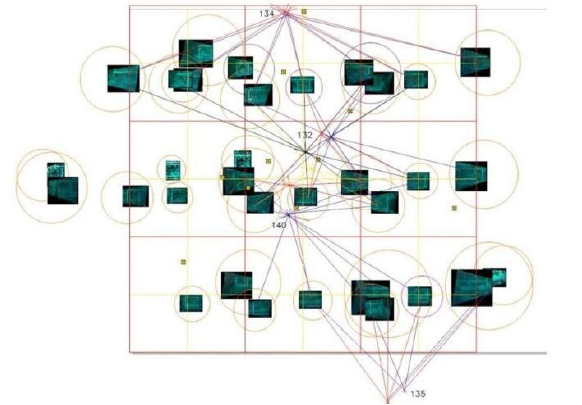
Figure 6. Disposition of the scaled images on the drawing grid (data processing: S.